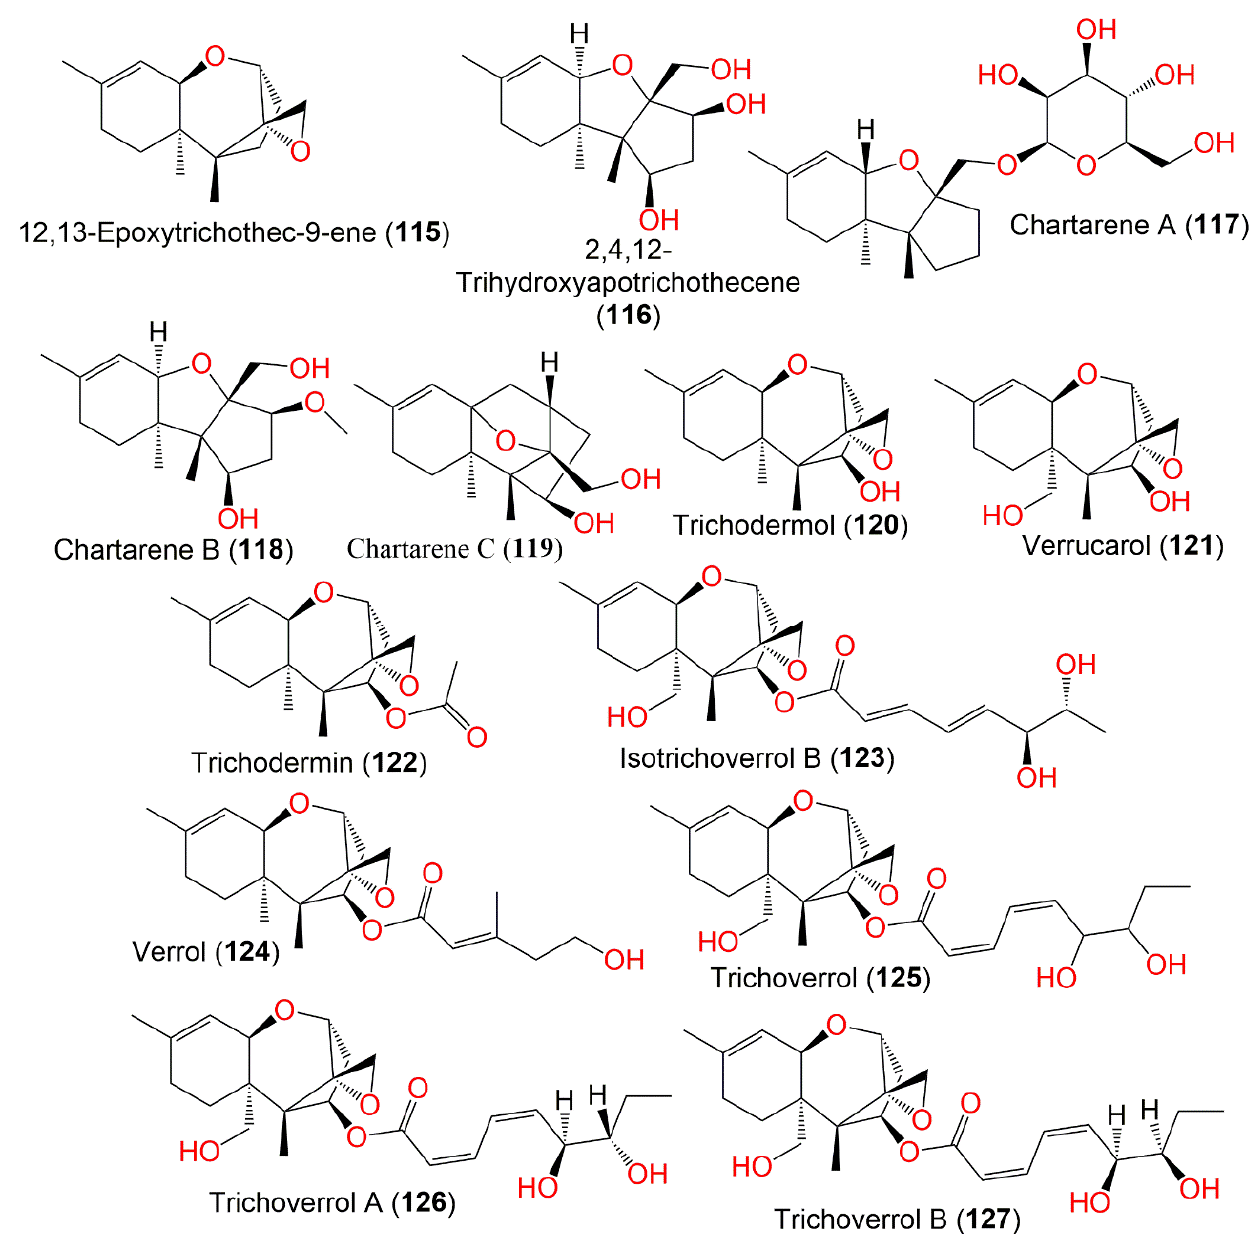
Figure 16. Structures of trichothecenes ( 115 – 127 ) reported from S . chartarum . Satratoxin G ( 142 ) and its biosynthetic precursor 129 were isolated from the culture acetonitrile extract using Michel–Miller SiO 2 CC and HPLC and characterized by ESI-CID (electrospray/ionization/collision-induced/dissociation). Compound 142 had a C-4 to C-15- linked cyclic ester ring, however, 129 possessed a C-4 extended carbon chain and no C-15- substituent. Satratoxin G was found to cause apoptosis of the nose and brain OSN (nasal- olfactory sensory neurons) of mice upon intranasal exposure [121]. Additionally, it induced apoptosis in PC-12 (neuronal cell model) through marked upregulation of p53, BAX,